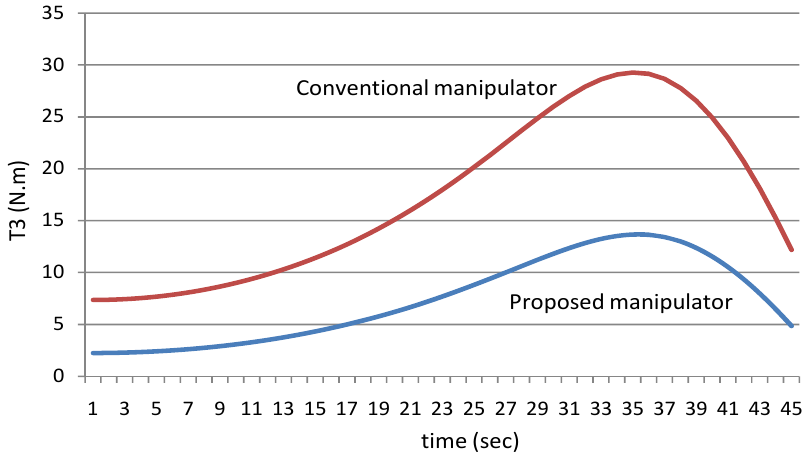
Figure 12. The values of the torques of the third joint using the both manipulators.